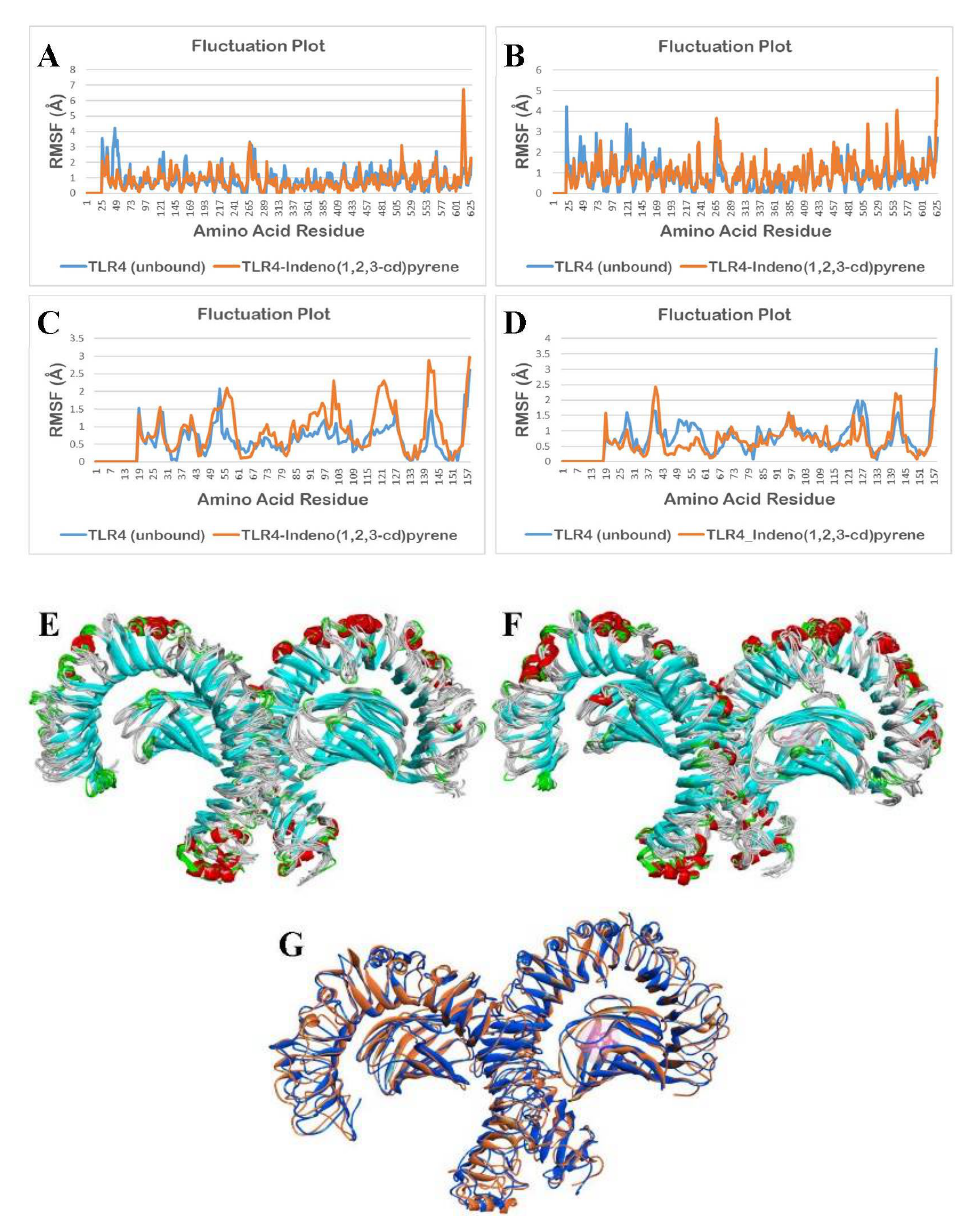
Figure 11. Molecular dynamics simulation of unbound and IP bound TLR4 structures: ( A ) fluctuation plot of the number of amino acid residues of unbound (blue) and bound structure (orange) of TLR4 chain A, ( B ) fluctuation plot of the number of amino acid residues of unbound (blue) and bound structure (orange) of TLR4 chain B, ( C ) fluctuation plot of the number of amino acid residues of unbound (blue) and bound structure (orange) of TLR4 chain C, ( D ) fluctuation plot of the number of amino acid residues of unbound (blue) and bound structure (orange) of TLR4 chain D, ( E ) super- imposition of unbound TLR4 structures from 0 ns to 10 ns, ( F ) superimposition of IP bound TLR4 structures from 0 ns to 10 ns, and ( G ) superimposition of unbound TLR4 (blue) at 0 ns and IP (pink) bound TLR4 (orange) at 10 ns.